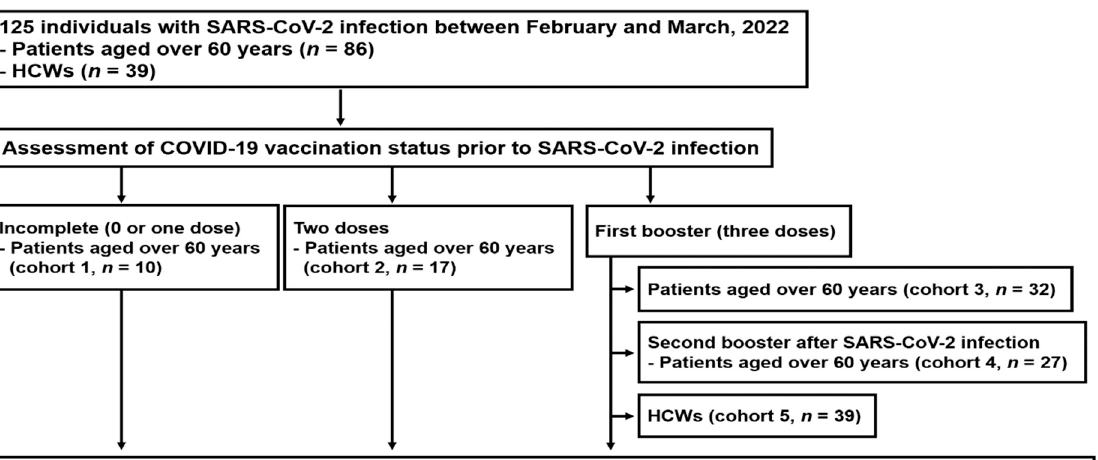
Figure 1 . Study population. Figure 1. Study